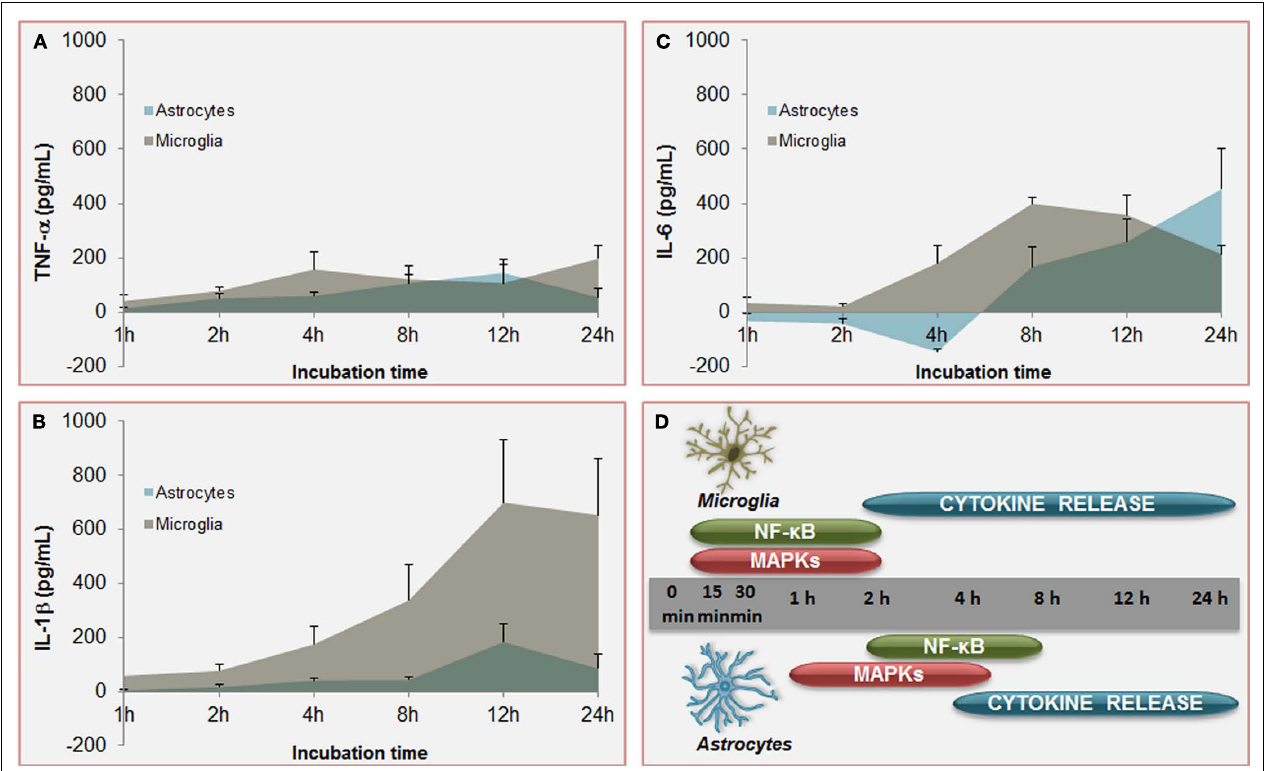
before being enhanced, IL-6 secretion by microglia is almost immediately induced by UCB.These timely differences in the secretion of pro-inflammatory cytokines between astrocytes and microglia should reside in the former activation of nuclear factor (NF)- κ B and mitogen-activated protein kinases (MAPKs) (D) in microglia than is astrocytes.These features corroborate the belief that microglia is activated earlier than astrocytes, thus promoting astrocytic activation. Data, presented as mean ± SEM, derived from Fernandes et al. (2006) and Silva et al.